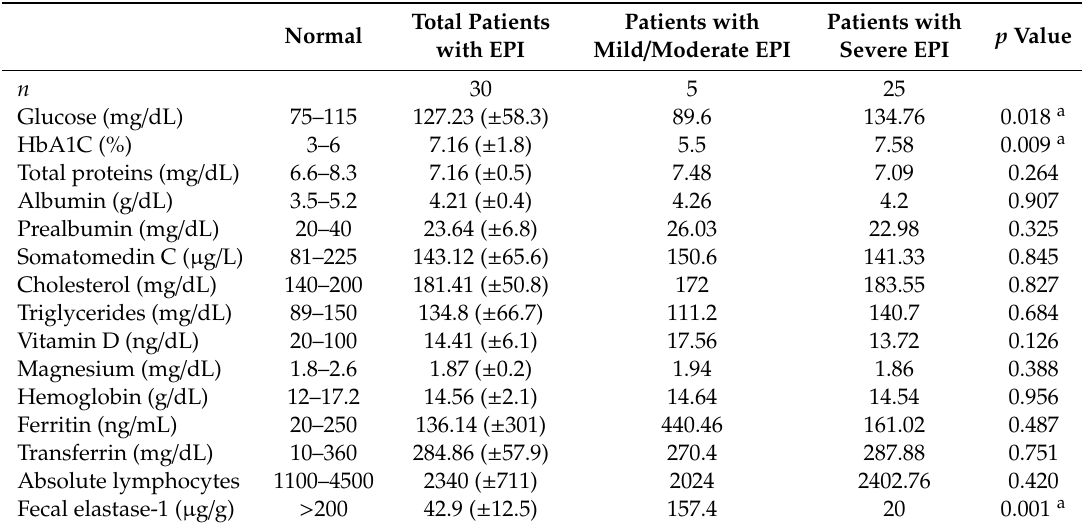
Table 8. Analytical parameters in patients with mild / moderate versus severe EPI. ( n = 30). Total Patients Patients with Patients with Normal with EPI Mild / Moderate EPI